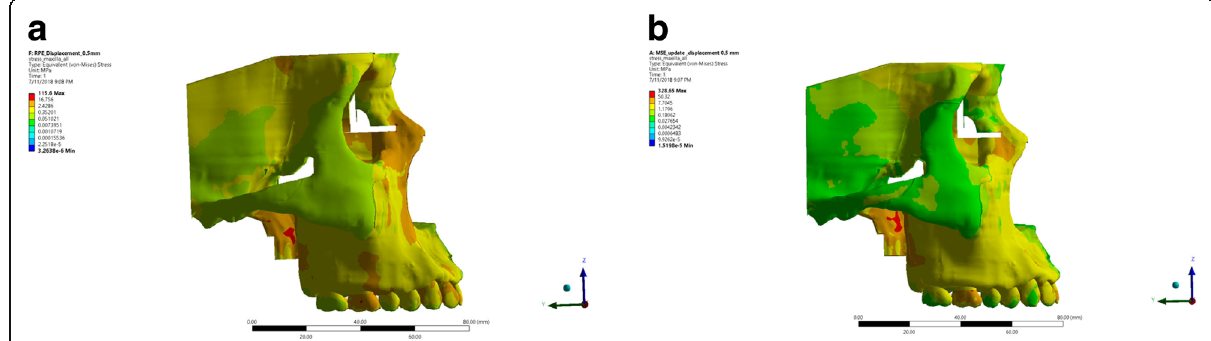
Fig. 8 Lateral aspect of stress distribution as the resut of expansion of RME ( a ) and MSE ( b )